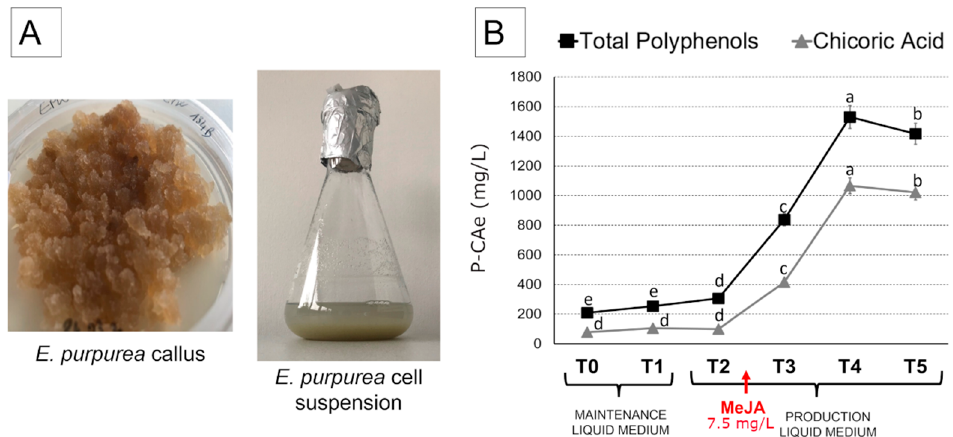
Figure 2. Panel ( A ): E. purpurea callus and cell suspension phenotype. Panel ( B ) : Quantitative UPLC-DAD analysis results on total polyphenols expressed as chicoric acid equivalent (P-CAe) in E. purpurea cell suspensions at each time-point. Three biological replicates were analysed for each sample. Different letters above the bars indicate statistically significant differences at p < 0.05 for ANOVA.